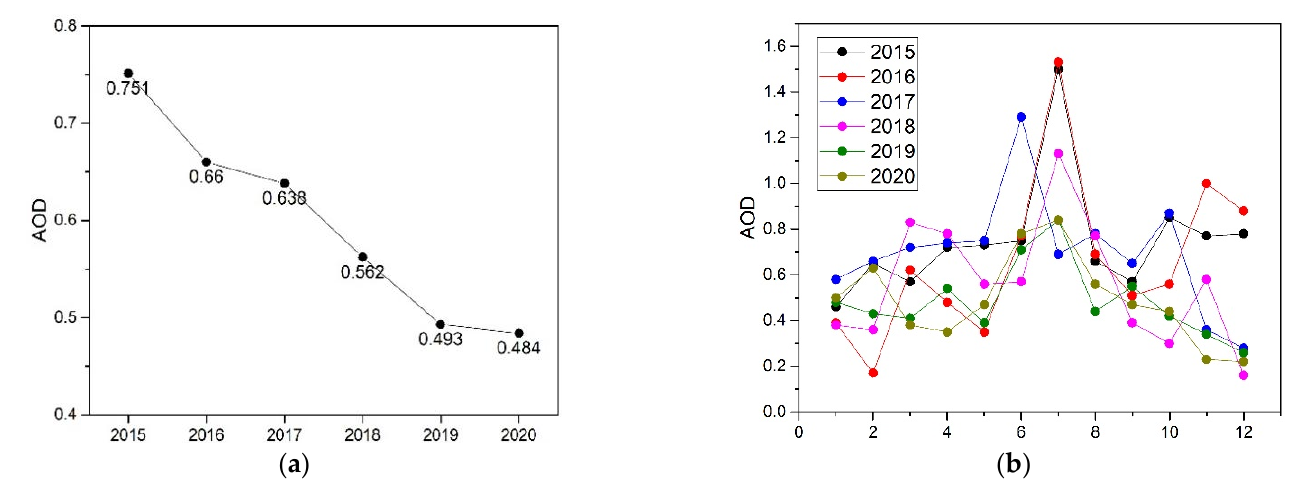
8 of 16 Figure 5. Verification of SBDART ADRF and AERONET ADRF at TOA, ATM and BOA. 3.4. Trends in MODIS AOD